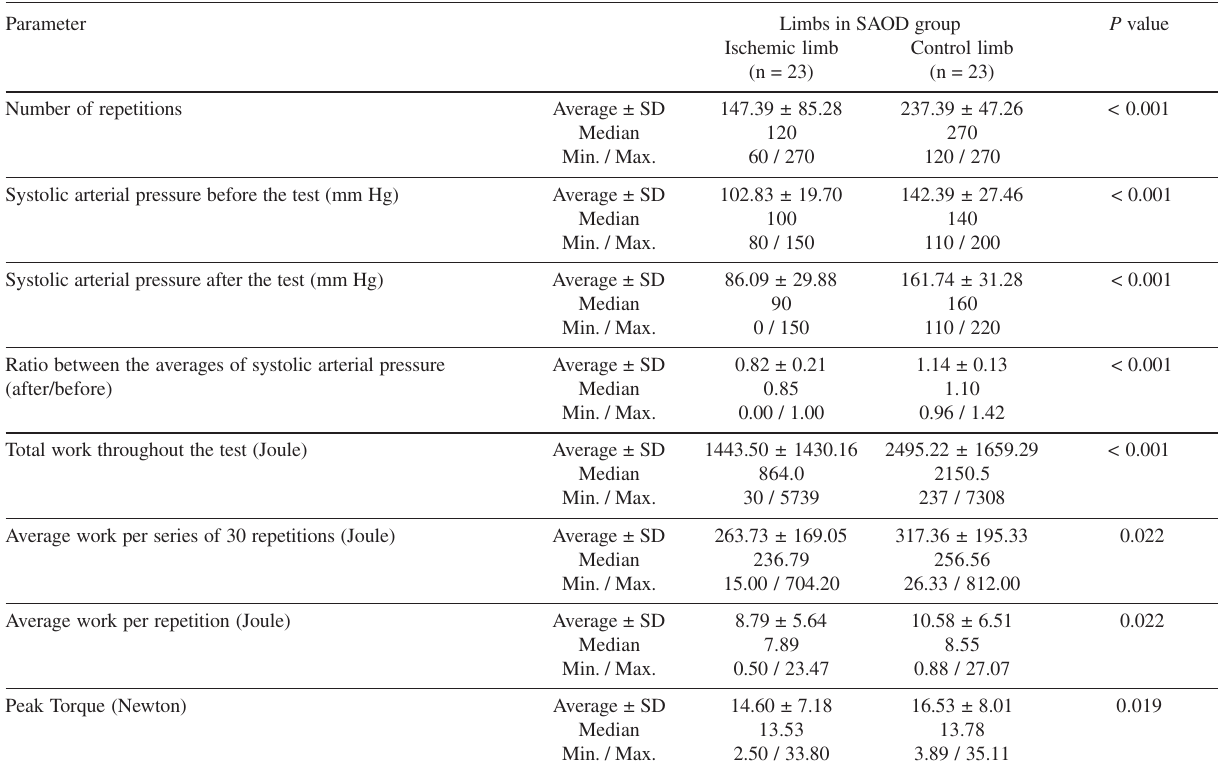
Table 3 - Parameters analyzed comparing the ischemic and control limbs in Subclavian artery occlusive disease (SAOD)